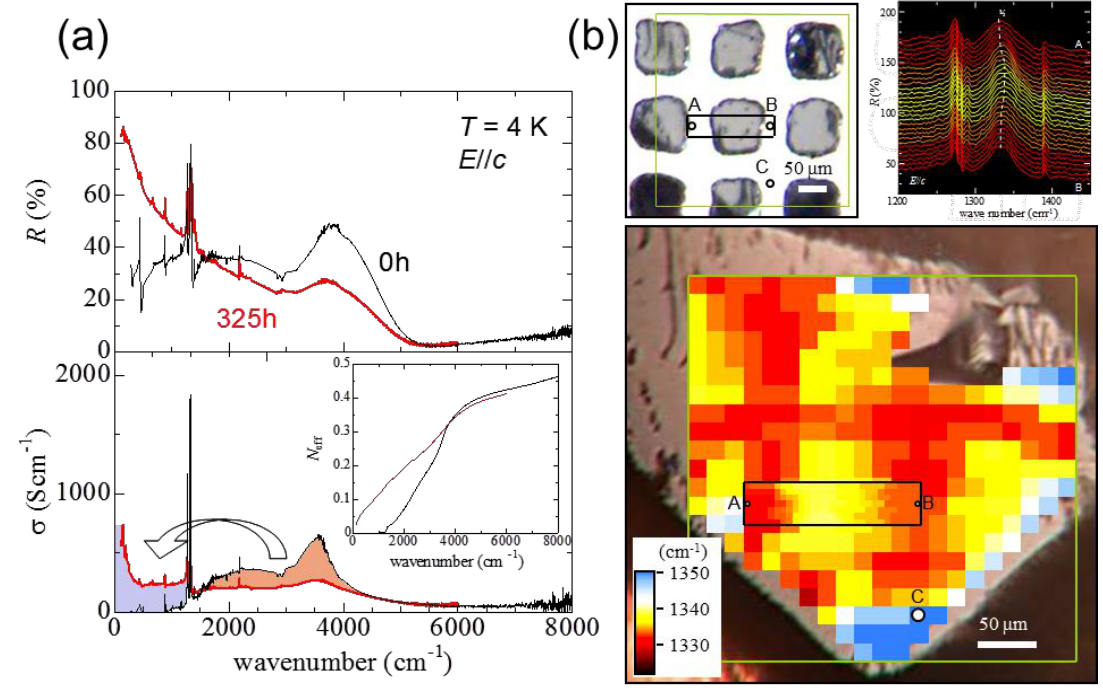
Figure 8. ( a ) Infrared optical reflectivity and conductivity of κ-(BEDT-TTF) before and after X-ray irradiation. The inset of the lower panel indicates the effective number of carries N ; ( b ) Scanning micro-region infrared reflectance spectroscopy (SMIS) eff scanning map of the partly X-ray irradiated X = Cu[N(CN) sample through the molybdenum mesh